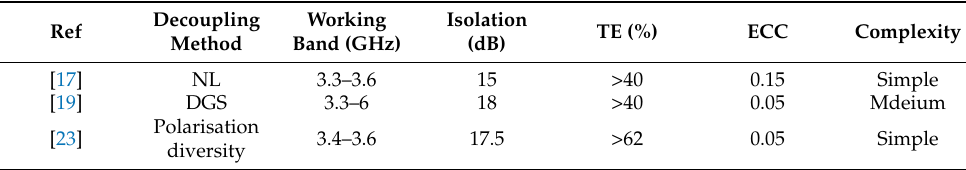
Table 1. Performance comparison with other smartphone MIMO